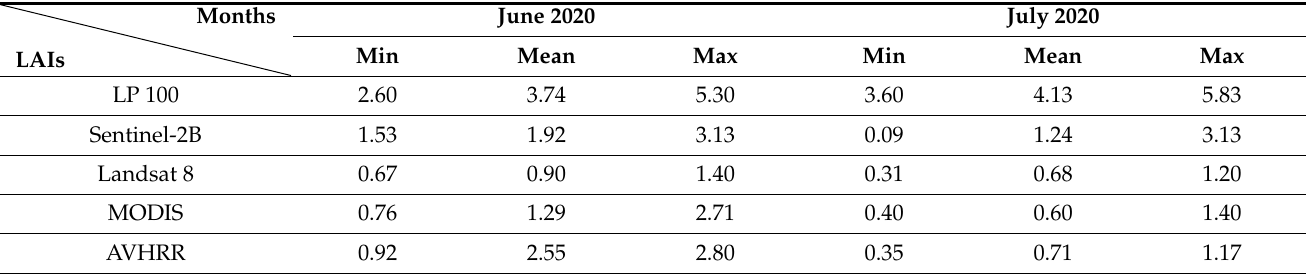
Table 3. Descriptive statistics of estimated LAI using LP 100 and different sensors extracted for sampling points in different months.